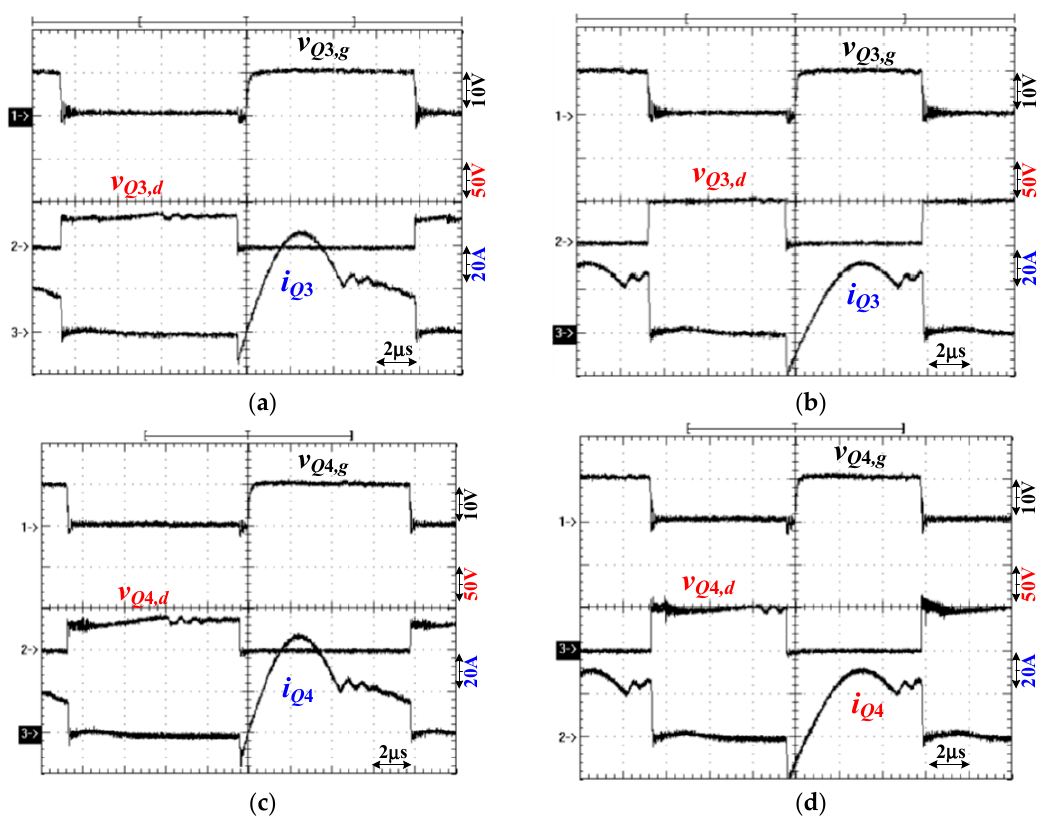
Figure 10. Test results of Q 3 and Q 4 under reverse power flow and 480 W (100% load) output with ( a ) Q 3 at V 2 = 38 V, ( b ) Q 3 at V 2 = 52 V, ( c ) Q 4 at V 2 = 38 V, and ( d ) Q 4 at V 2 = 52 V.